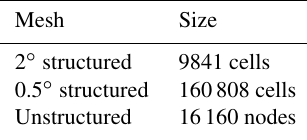
Table 1. Mesh sizes considered in this